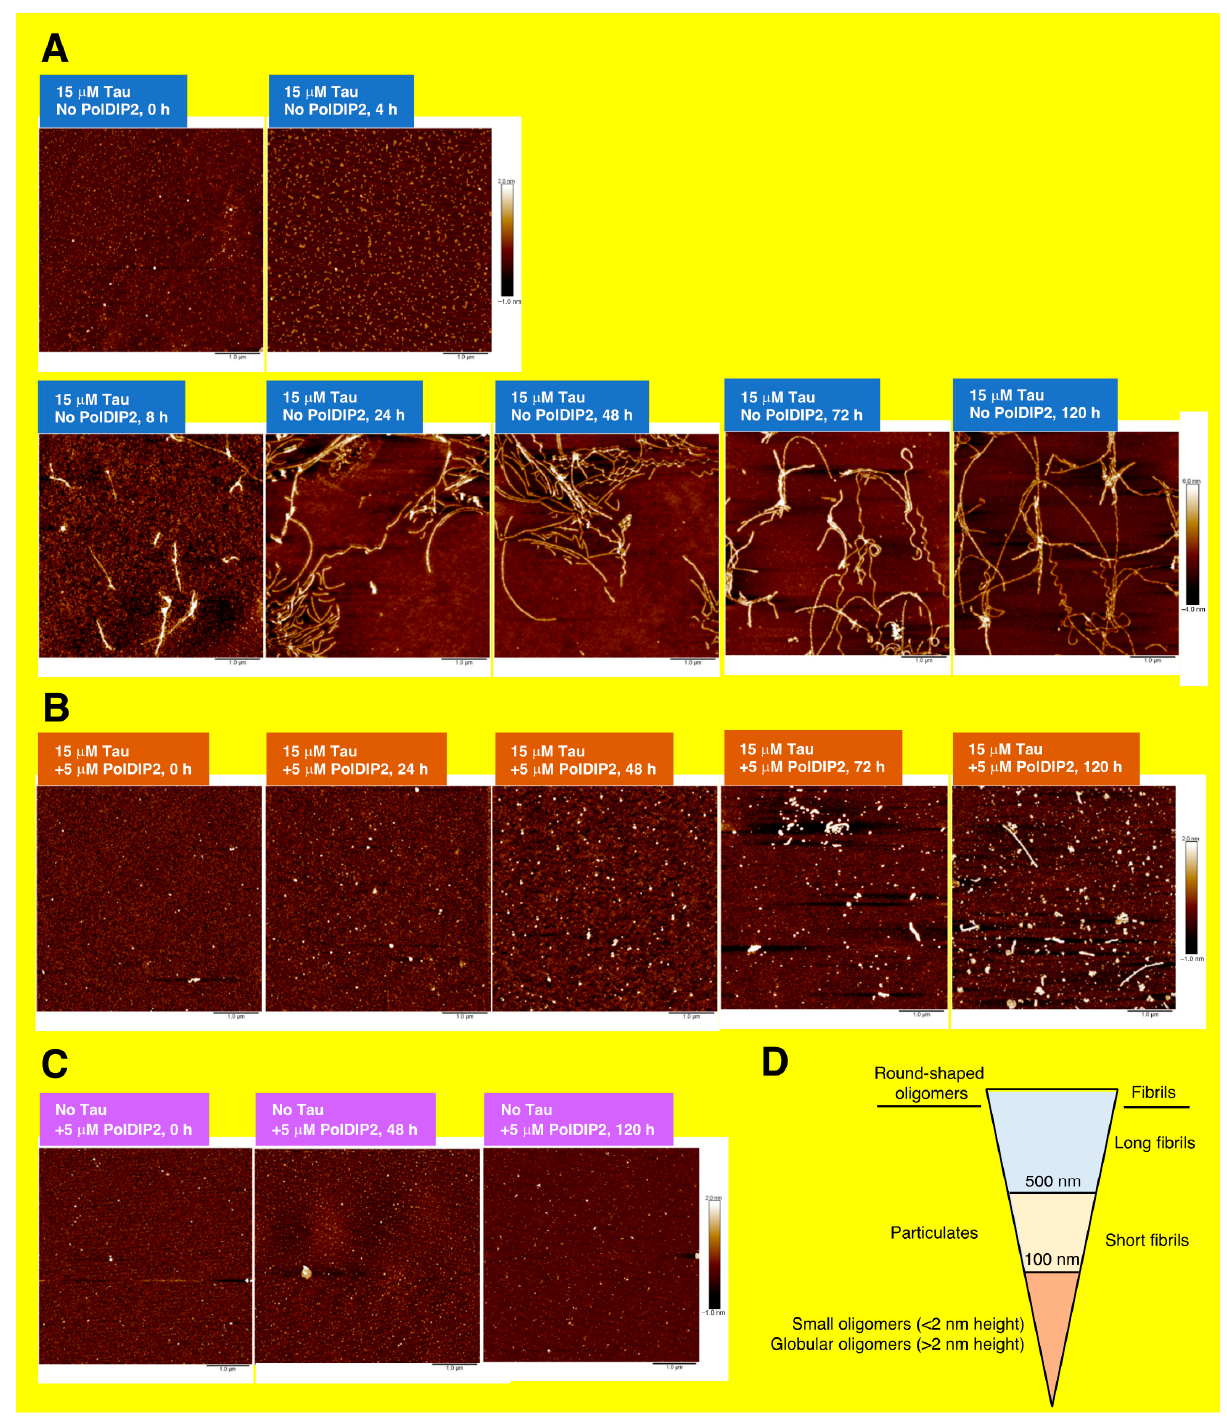
Figure 3. PolDIP2 inhibits Tau fibril formation. ( A – C ) AFM analysis of Tau fibrils and globular oligomers in the absence and presence of PolDIP2. AFM images of samples at the different indicated time points: ( A )15 µM Tau, ( B )15 µM Tau with 5 µM PolDIP2, and ( C ) 5 µM PolDIP2. Color scales in the z -axis are indicated next to each panel. The size of the scans is 5 µm × 5 µm. ( D ) A schematic description explaining the definitions used in this study to describe the AFM-observed fibrils and oligomers. We distinguish the round-shaped oligomers into “Particulates” (>100 nm diameter), “globular oligomers” (>2 nm height and <100 nm diameter) and “small oligomers” (<2 nm height and <100 nm diameter). The fibrils were sorted into “short fibrils” (100–500 nm length) and “long fibrils” (>500 nm length). The diameter was measured at half of the maximal height of the